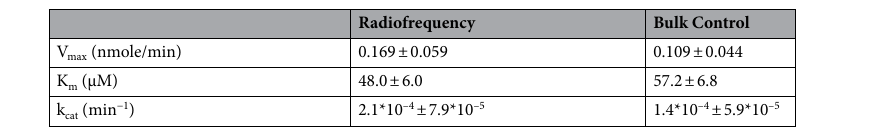
Table 1. Summary of kinetics data for Michaelis Menten kinetics model. Uncertainty is included from the lines of fit and propagated through with the known uncertainty in enzyme concentration for the k cat calculation.